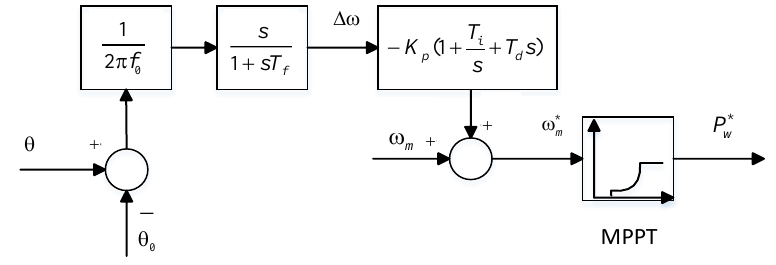
Figure 2. Damping control for DFIG.